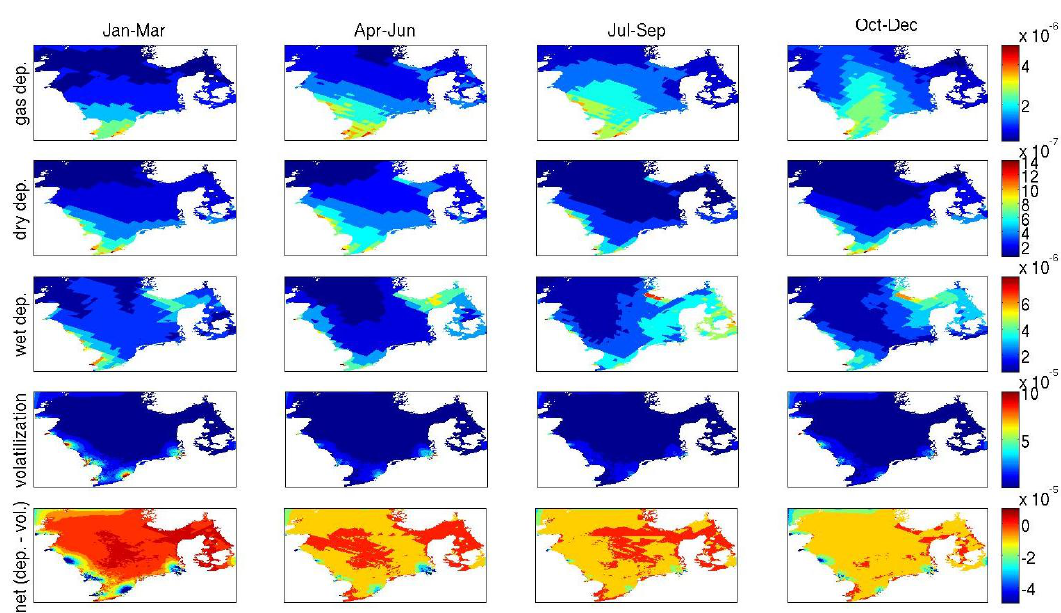
Figure 10. Distributions of quarterly (3 month) averaged rates of gas deposition ( top row ), dry deposition ( 2nd row ), wet deposition ( 3rd row ), volatilization ( 4th row ), and net air-sea exchange ( bottom row ) for PCB 153 in 2004. Rates are in (ng∙m −2 ∙s −1 ). Note: colorbar scales shown on 3rd column panels are used in connection with the left 3 panels. Note the change in scales for autumn (right figures), which are reduced relative to winter, spring and summer. Scales vary from row to